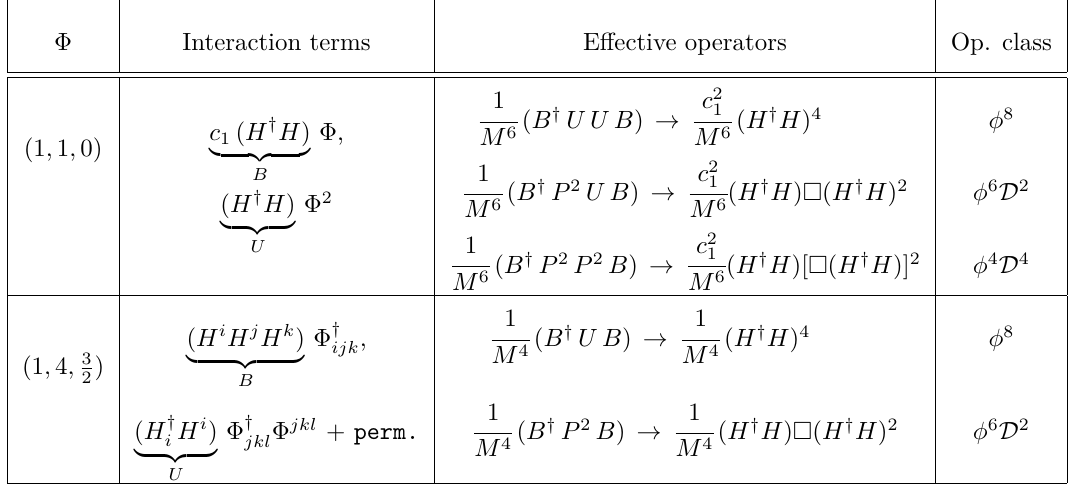
Table 4. Origin of D8 SMEFT operators through tree-level integrating out from UV models containing (i) a real singlet scalar Φ ∈ (1 , 1 , 0) and (ii) an SU(2) i, j, k, l refer to SU(2) indices and in the last row ”perm.” refers to the possible permutations of these